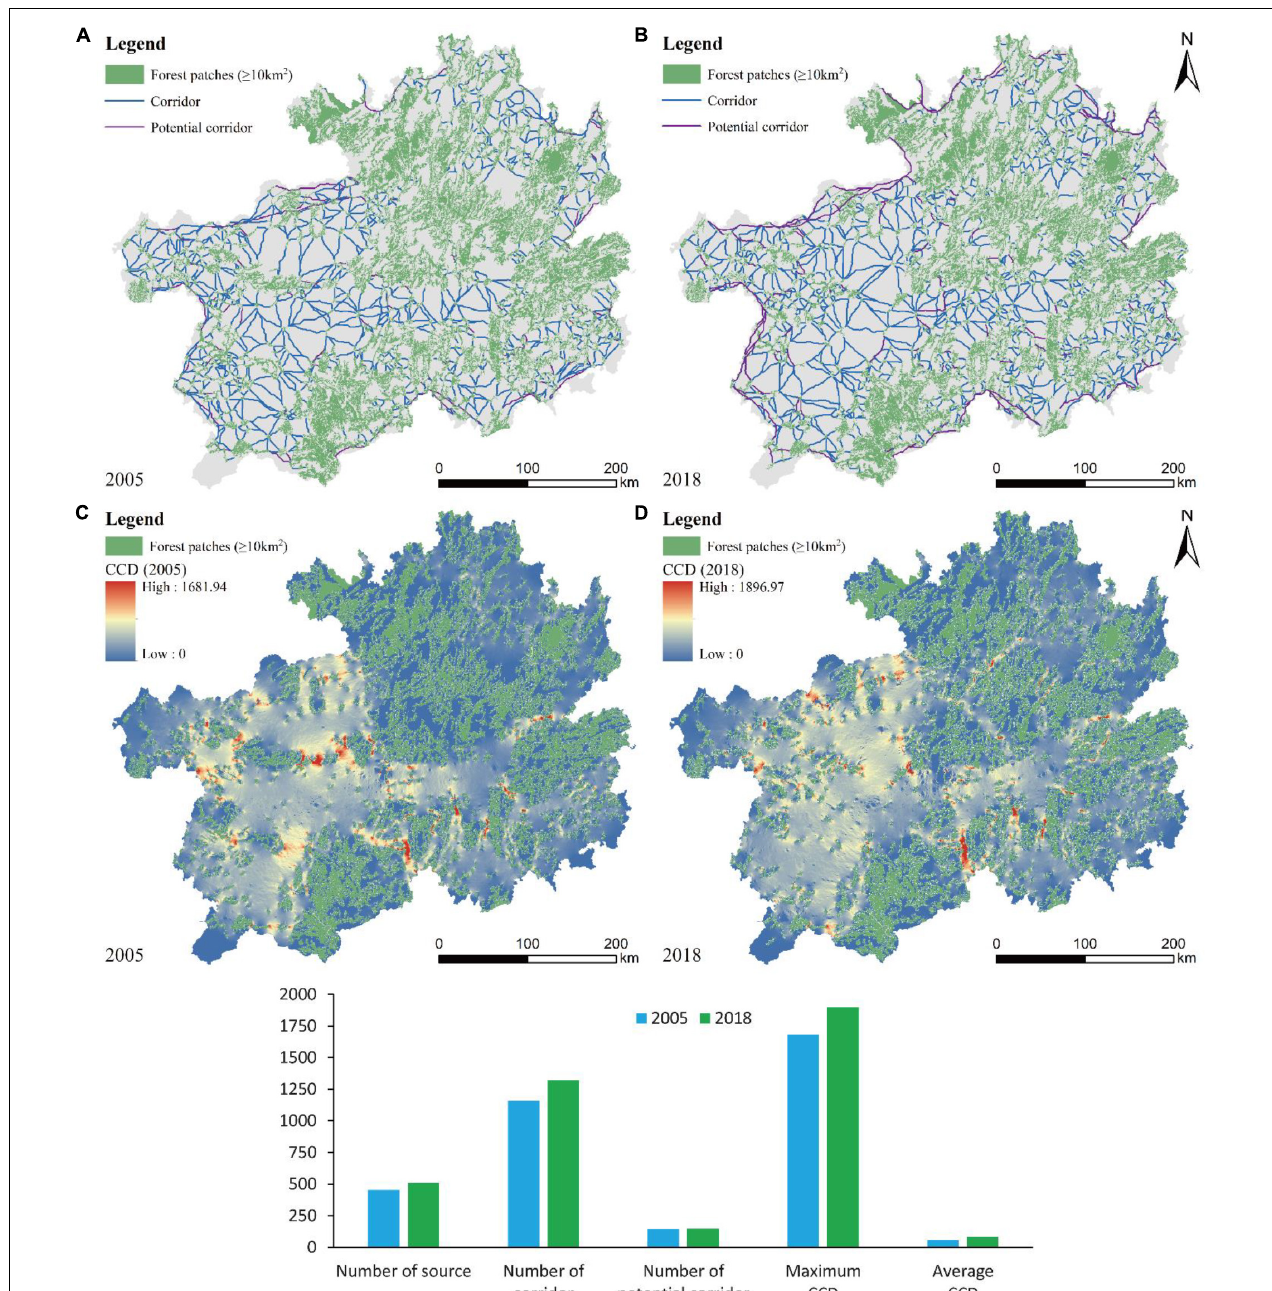
FIGURE 5 | (A,B) Spatial distributions of ecological sources and corridors in 2005 and 2018. (C,D) Cumulative current density (CCD) maps for 2005 and 2018.